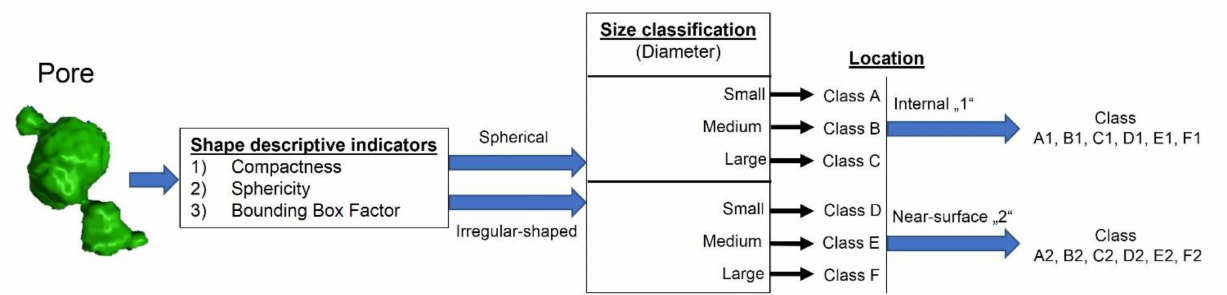
Figure 3. Pore classification procedure using X-ray data.